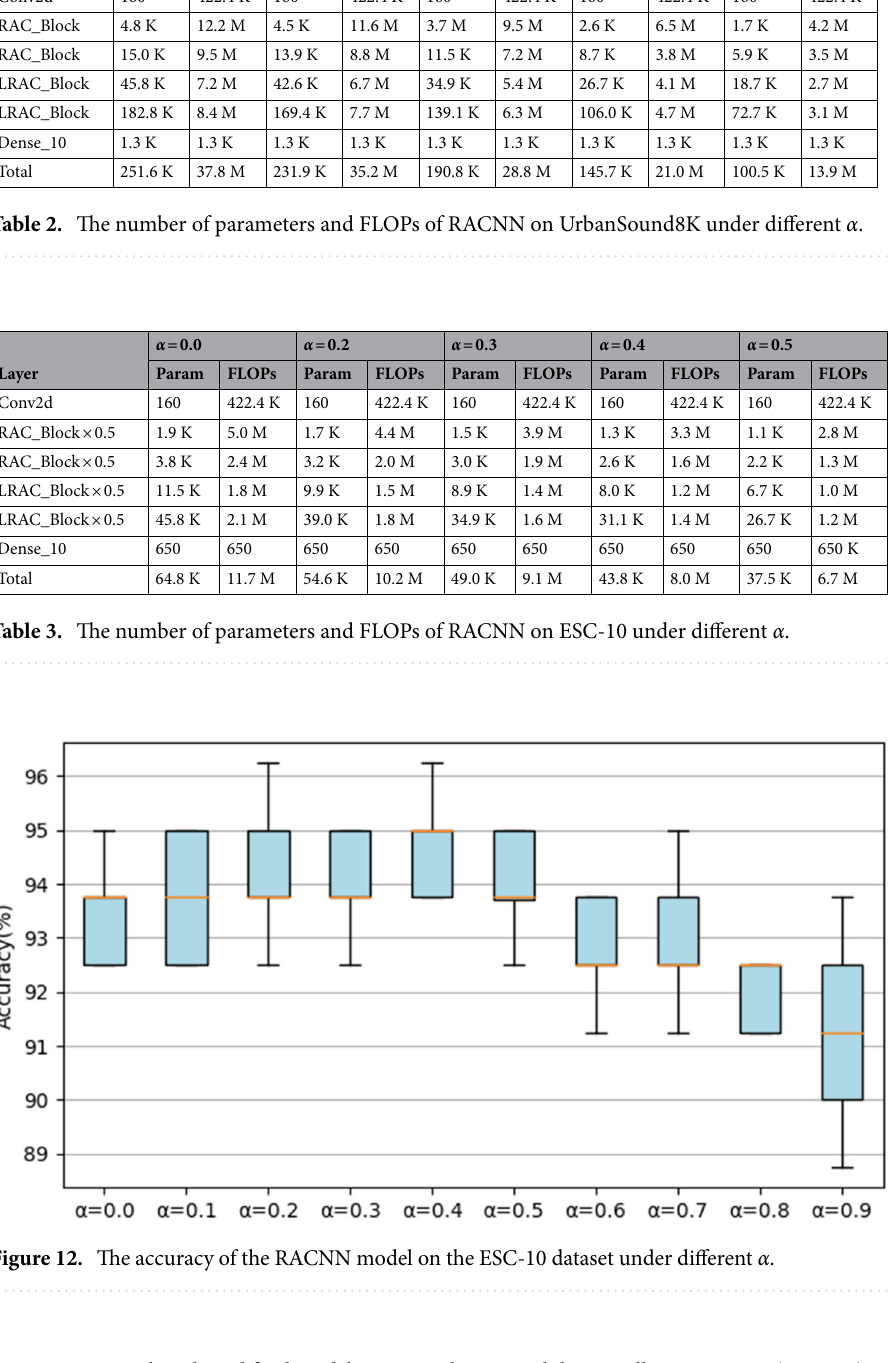
Figure 12. The accuracy of the RACNN model on the ESC-10 dataset under different α